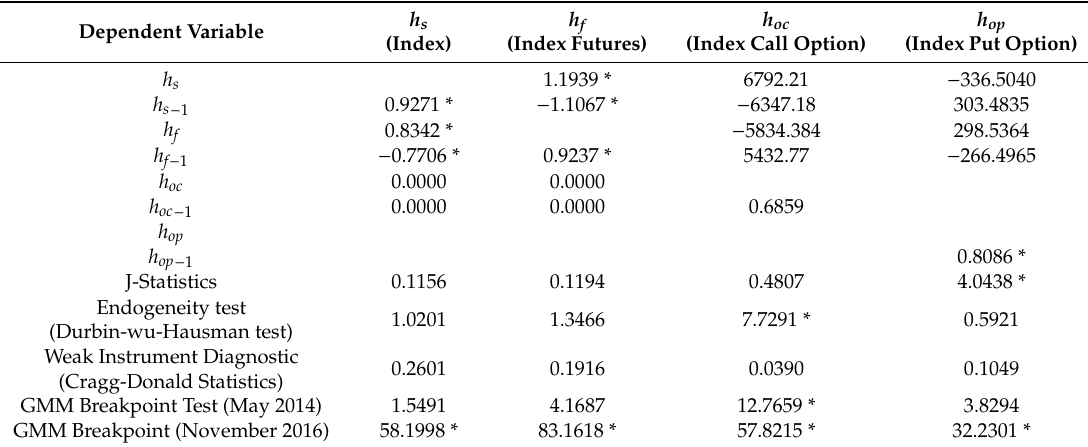
Table 3. Regression Analysis results-GMM (Generalized method of